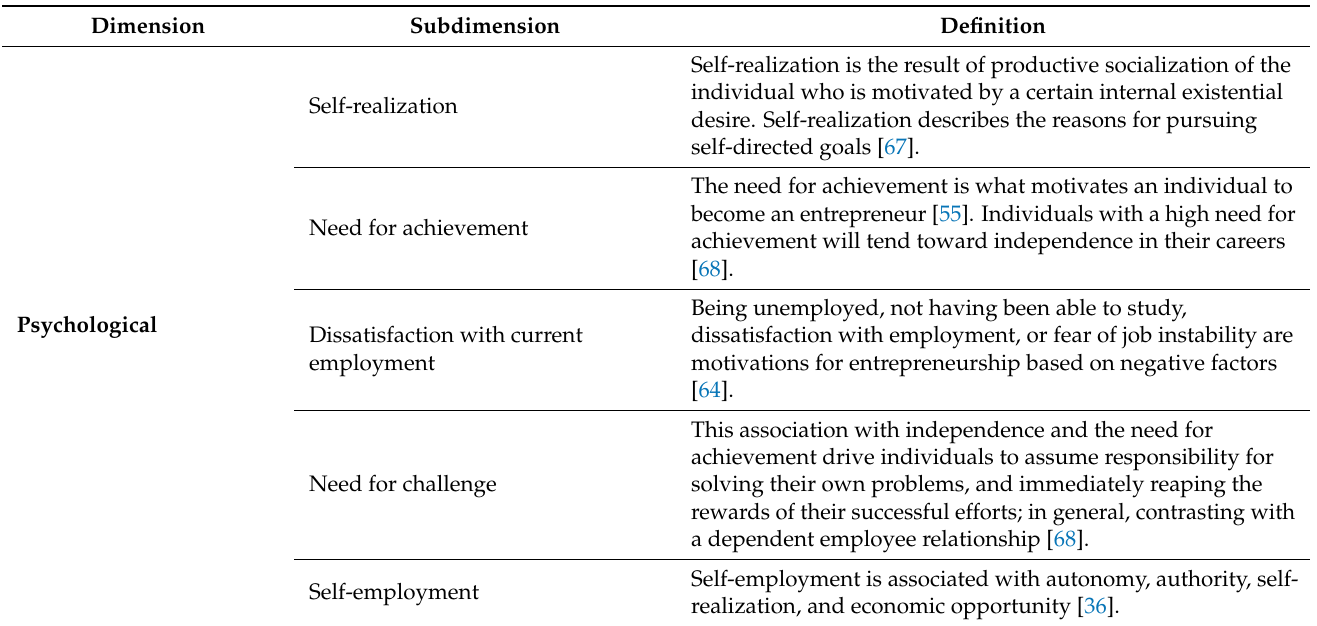
Table 3. Psychological